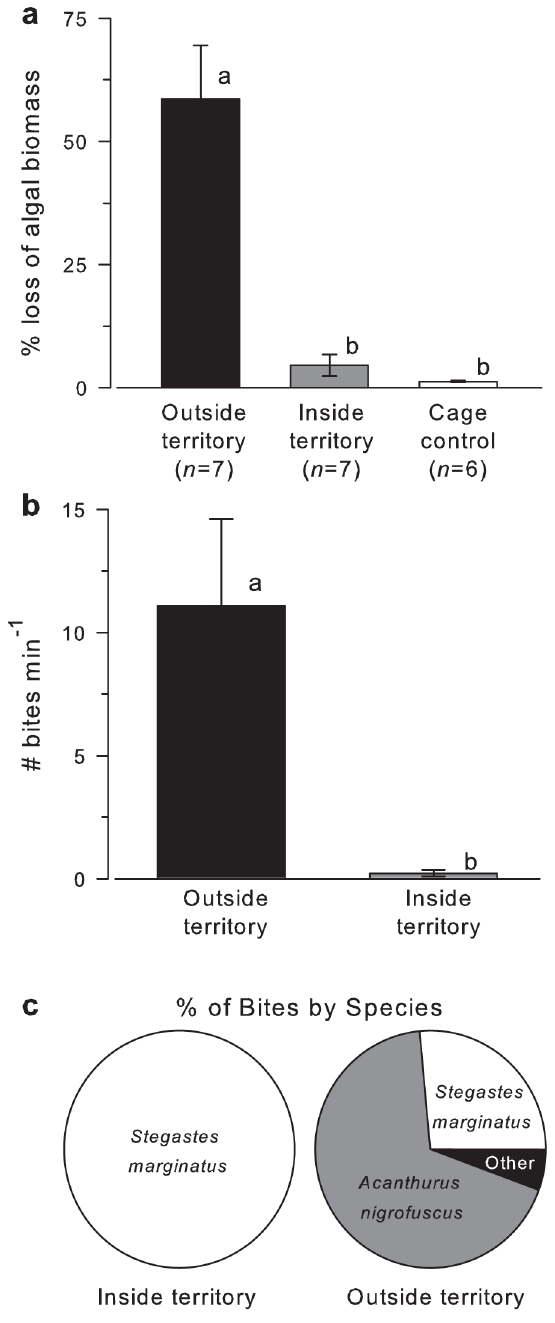
Figure 2. Herbivore grazing intensity on A.spicifera was highest outside the territorial defenses of S.marginatus . A) Percent loss of A. spicifera algal biomass from tethers placed inside S. marginatus territories, outside territories, or in caged controls. B) Number of bites min 2 1 on tethered A. spicifera placed inside and outside S. marginatus territories. C) Percentage of bites taken by different fish species inside and outside S. marginatus territories. Data are plotted as mean 6 SE and bars with different letters indicate significant differences at p , 0.05.